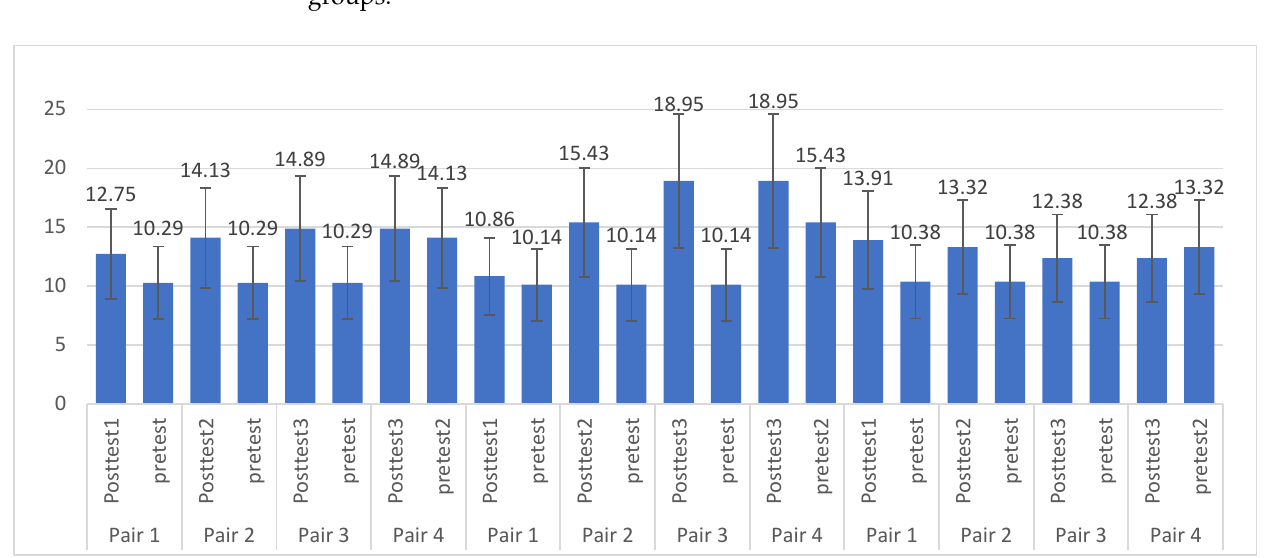
Figure 4. Mean Differences Between Paired Tests Within the Experimental Groups.